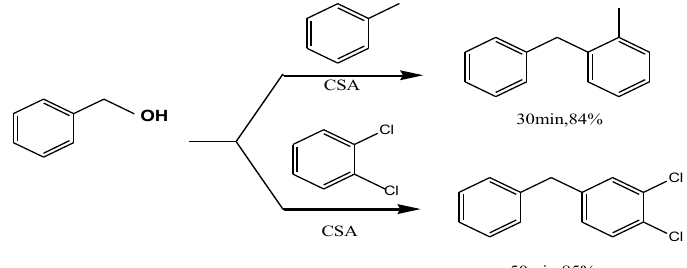
Figure 7. Demonstration of Friedel-Crafts alkylation reaction with benzene in the presence of supported cellulose sulfonic acid on silica